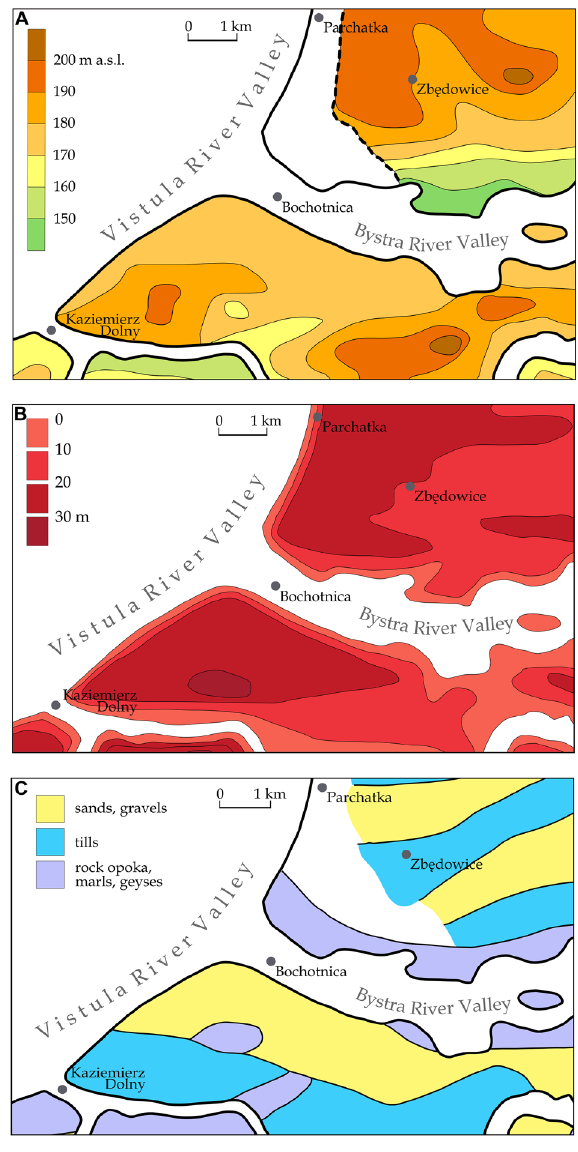
Fig. 2. Geological structure of the research